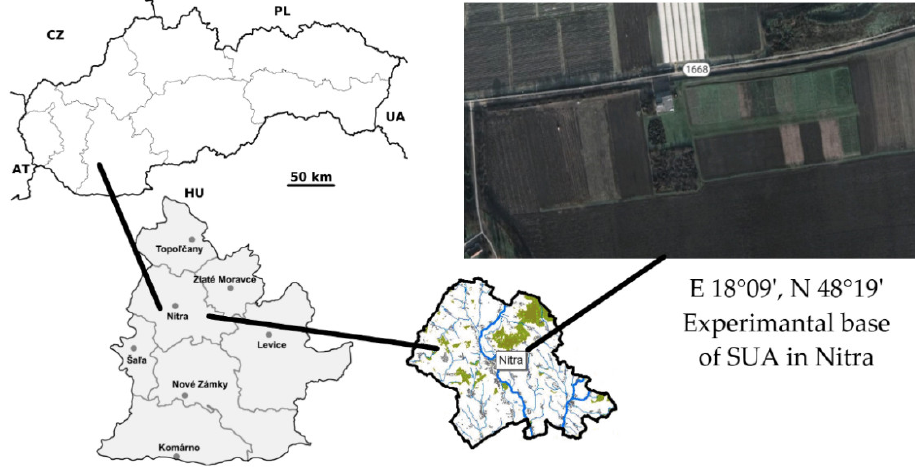
Figure 11. Location of experimental station of the Slovak University of Agriculture in Nitra.